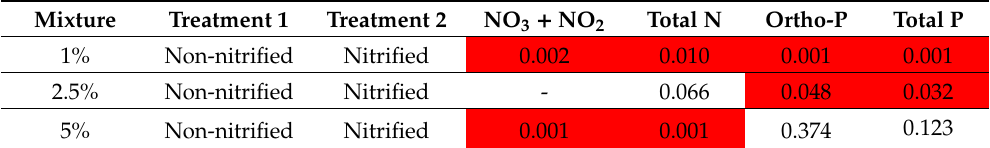
Table 11. Significant di ff erences between concentrations of each form of nitrogen and phosphorus before and after nitrification in the untreated PHWW mixtures were calculated using the Tukey HSD method, and the p -values are presented for each treatment comparison. Significant di ff erences ( p < 0.05) are highlighted in red for convenience. The “—“ for the 2.5% mixture signifies that the mean concentrations before and after nitrification were both